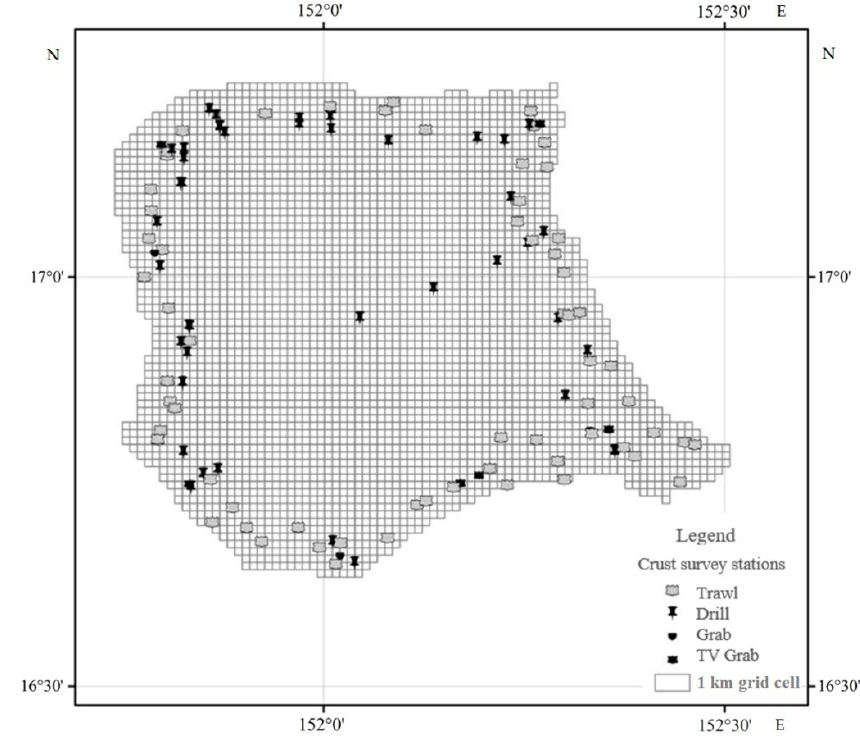
Figure 7. Divisions of the geological grid unit.